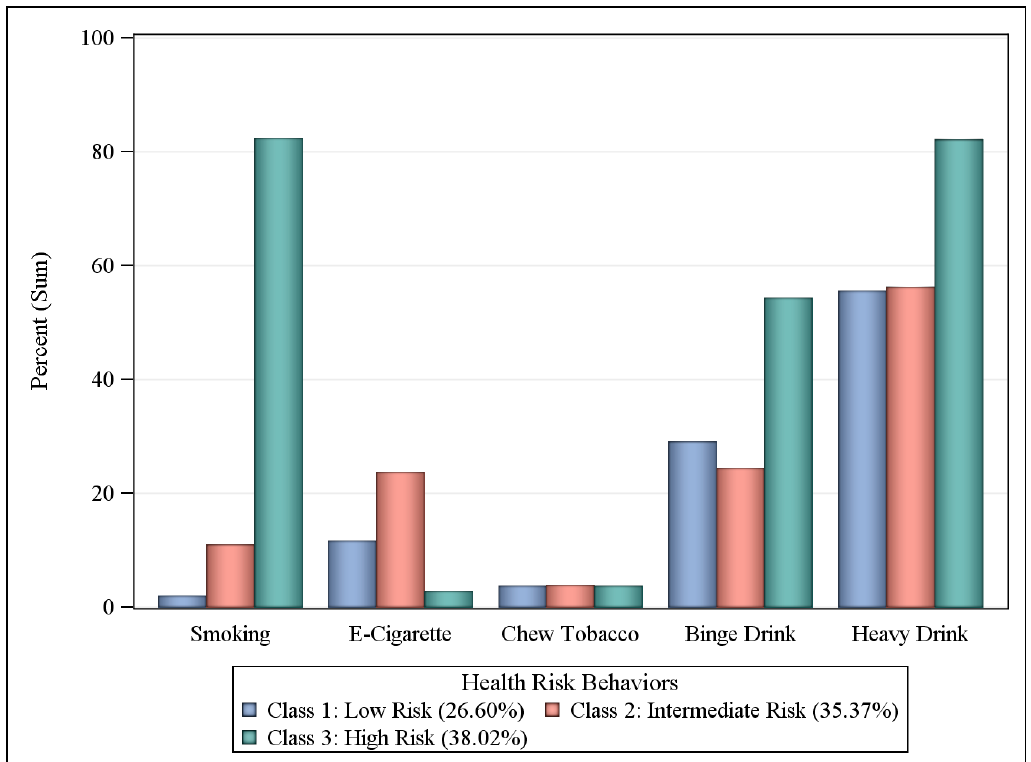
Figure 3. Prevalence probabilities of substance use and abuse behaviors by latent class, workers with COPD in KY, TN, NC, and WV BRFSS respondents, 2016 and 2017. Binge drinking defined as ≥ 5 drinks for men or ≥ 4 drinks for women on one occasion during the past 30 days. Heavy drinking is defined as men having > 14 drinks per week and women having > 7 drinks per week. Behaviors refer to the past 30